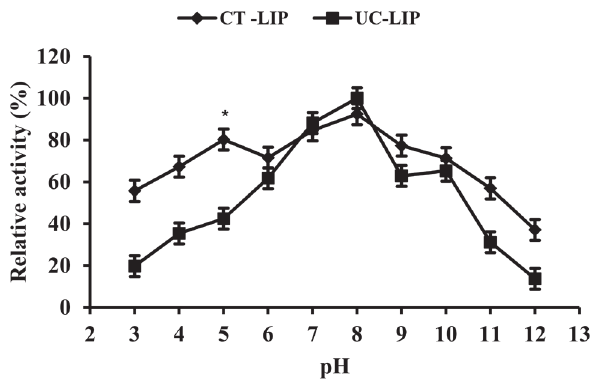
Figure 2. Effect of different pH on lipase relative activity. Data were presented with mean±standard deviation (n = 6). Vertical error bars show standard deviation of measured relative activity (* p<0.05).